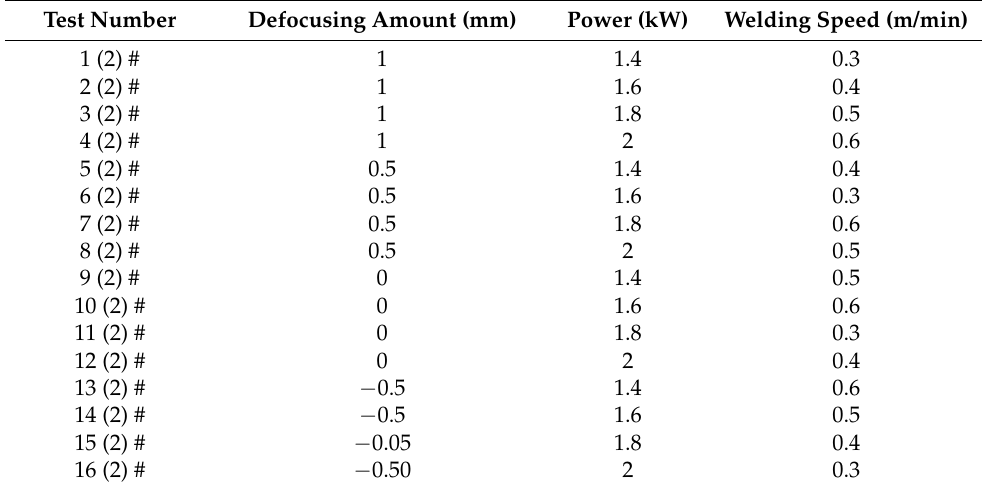
Table 2. Three-factor and four-level (L16 (34)) orthogonal test schemes for laser welding of Mo–5Re sheets with a thickness of 2 mm.